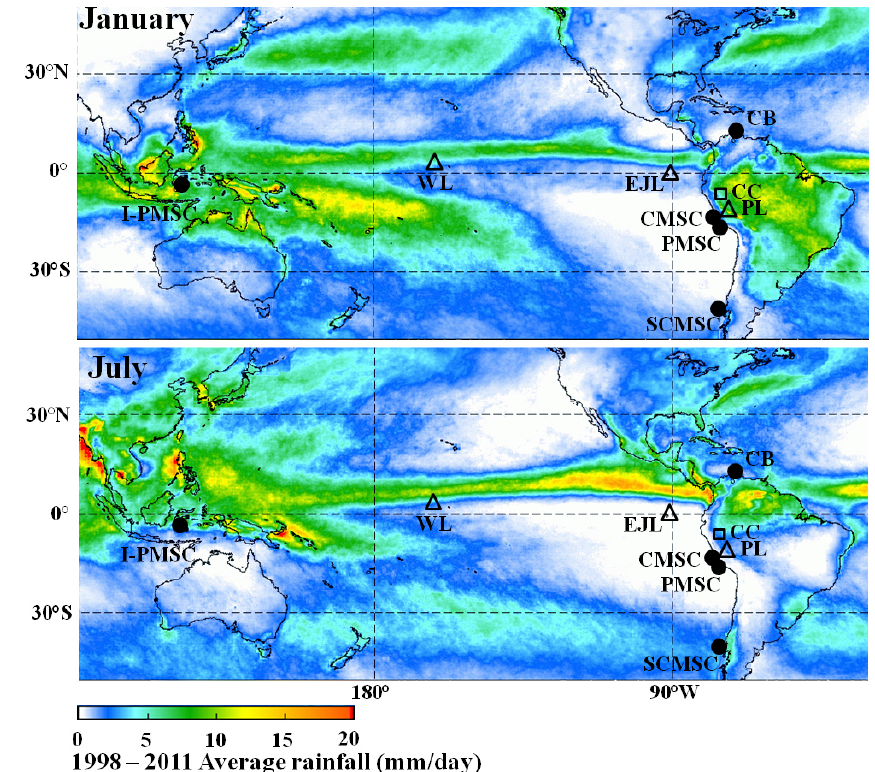
Fig. 1. Seasonal changes in mean precipitation derived from the Tropical Rainfall Measuring Mission (TRMM). Figures modified from the NASA/GSFC website available at http://trmm.gsfc.nasa.gov/. Top panel: mean precipitation during austral summer. Bottom panel: mean precipitation during austral winter. The symbols and abbreviations indicate the position and the records as discussed in the text: I-PMSC, Indo-Pacific Marine sediment core (Oppo et al., 2009); WL, Washington Lake (Sachs et al., 2009); CB, Cariaco Basin (Haug et al., 2001); EJL, El Junco lake (Conroy et al., 2009); CC, Cascayunga cave (Reuter et al., 2009); PL, Pumacocha lake (Bird et al., 2011); CMSC, Callao marine sediment core (Rein et al., 2005); PMSC, Pisco marine sediment cores (the present study); SCMSC, Southern Chile marine sediment core (Lamy et al., 2001). The circles indicate the marine sediment cores, the square indicates the speleothem, and the triangles indicate the lake sediment